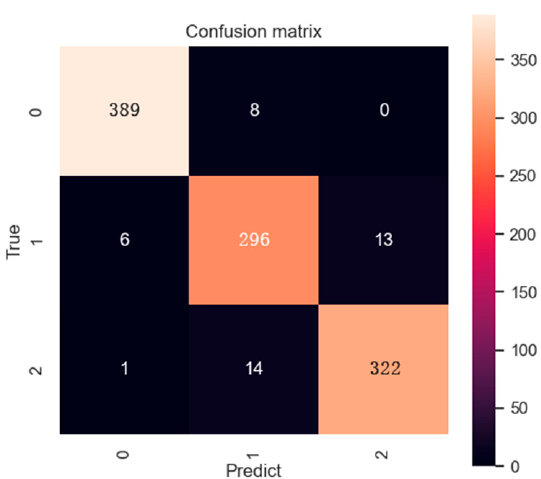
Figure 6. The recognition result confusion matrix of DenseNet121.